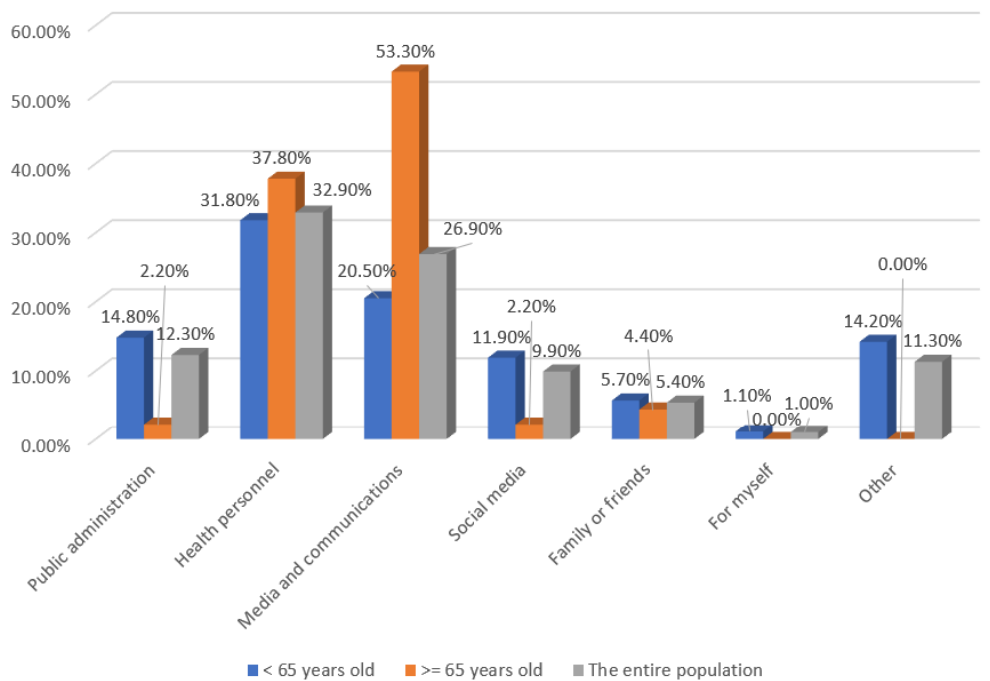
Figure 1. Main means of information about the influenza vaccination in the adult population and by age.